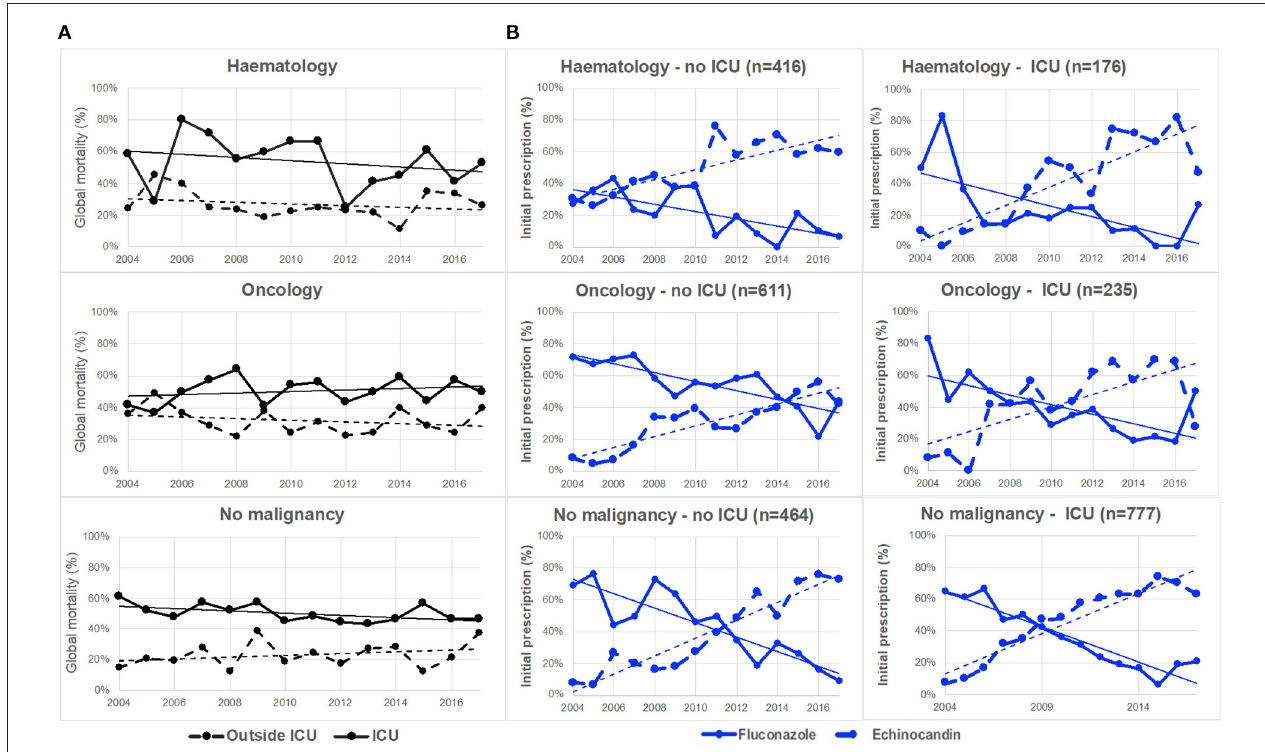
FIGURE 1 | Evolution of global mortality and first-line antifungal drug prescription in patients with hematological malignancy, oncology or no malignancy, inside or outside intensive care unit (ICU) (YEASTS program, Paris area, 2004–2017). (A) Global mortality did not change significantly over time inside (solid black line) and outside (dotted black line) ICU in the various categories of patients. (B) The evolution of fluconazole (solid blue line) and echinocandins (dotted blue line) prescription significantly ( p < 0.001) differed inside and outside ICU in the three populations of patients. The switch from fluconazole to echinocandins as first-line therapy did not occur at the same date in the six populations